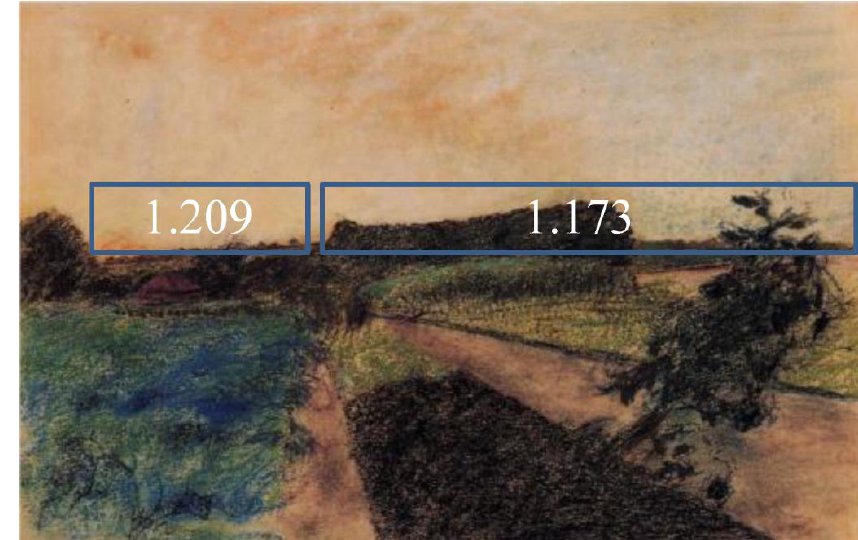
Fig. C5. Edgar Degas, Landscape on the Orne, c. 1884. Corresponding R/G ratios were averaged inside each